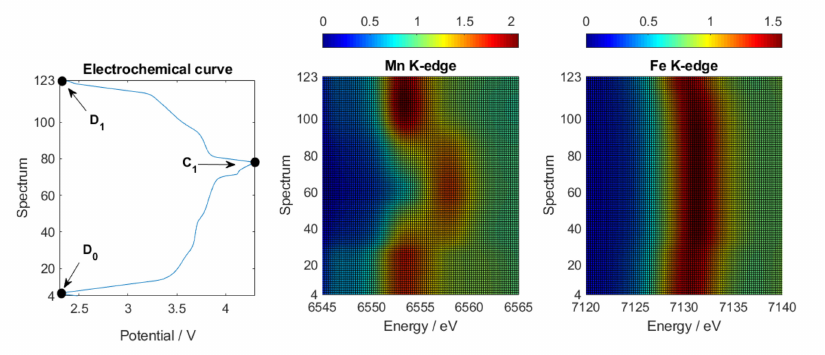
Figure 4. X-ray absorption fine structure (XAFS) operando dataset at the Mn and Fe K-edges and the respective electrochemical curve.